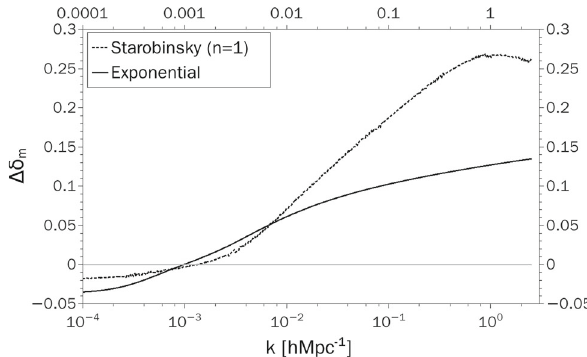
( R ) /δ (cid:3) CDM ) − 1 as functions of k , where δ f ( R ) Fig. 2 (cid:13)δ m ≡ (δ f m m δ (cid:3) CDM m are the matter densities of perturbations in the f models with the dynamical background and that in the (cid:3) CDM model, respectively, while the legends are the same as those in Fig. 1